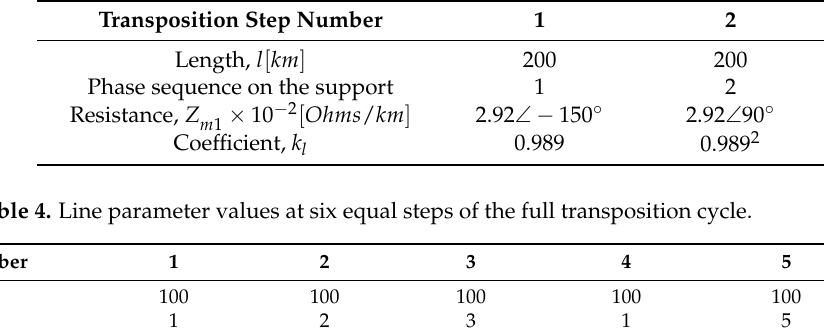
Table 3. The values of the line parameters at three equal steps of the full transposition cycle.